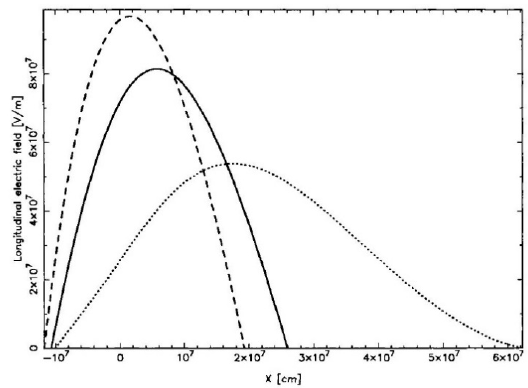
Figure 3. Acceleration electric field in a pulsar outer gap. The dashed, solid, and dotted curves correspond to the case of j cr = 0.01, 0.03, and 0.0592. From [78].